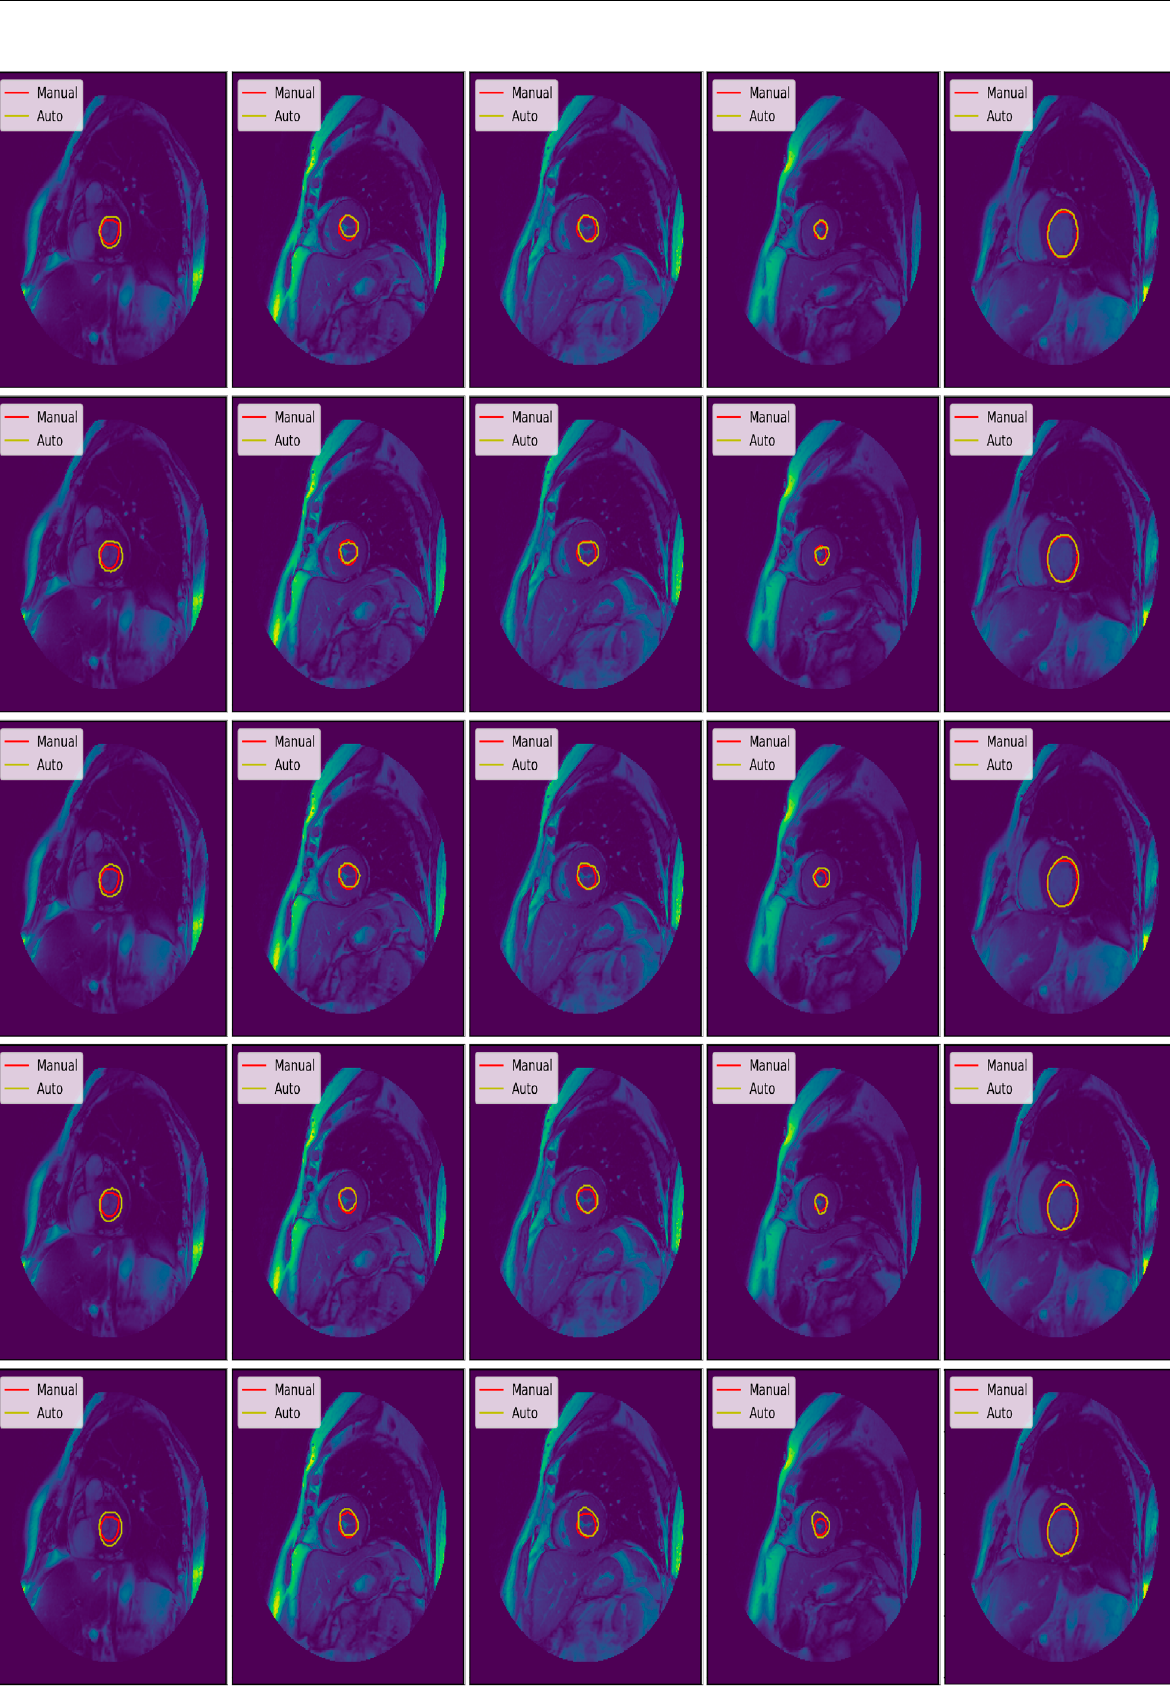
Figure 14. Automatic and manual segmentation results of the endocardium from the testing set of a normal subject (SC-N).